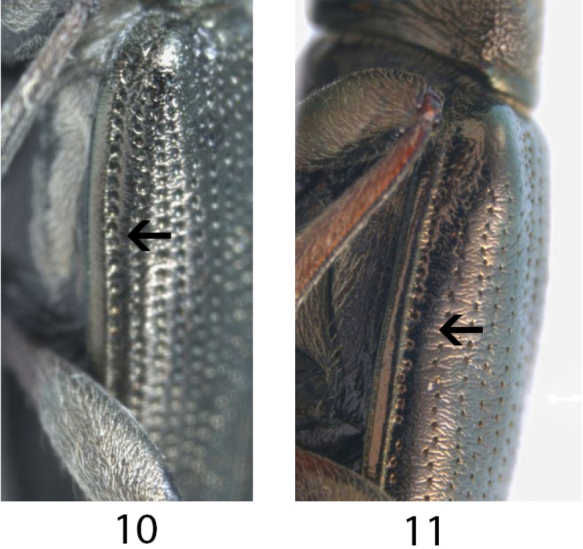
Elytral epipleuron. 10Donaciaclavareaui, 10th interval narrower than epipleuron 11D.fukiensis, 10th interval broader than epipleuron.